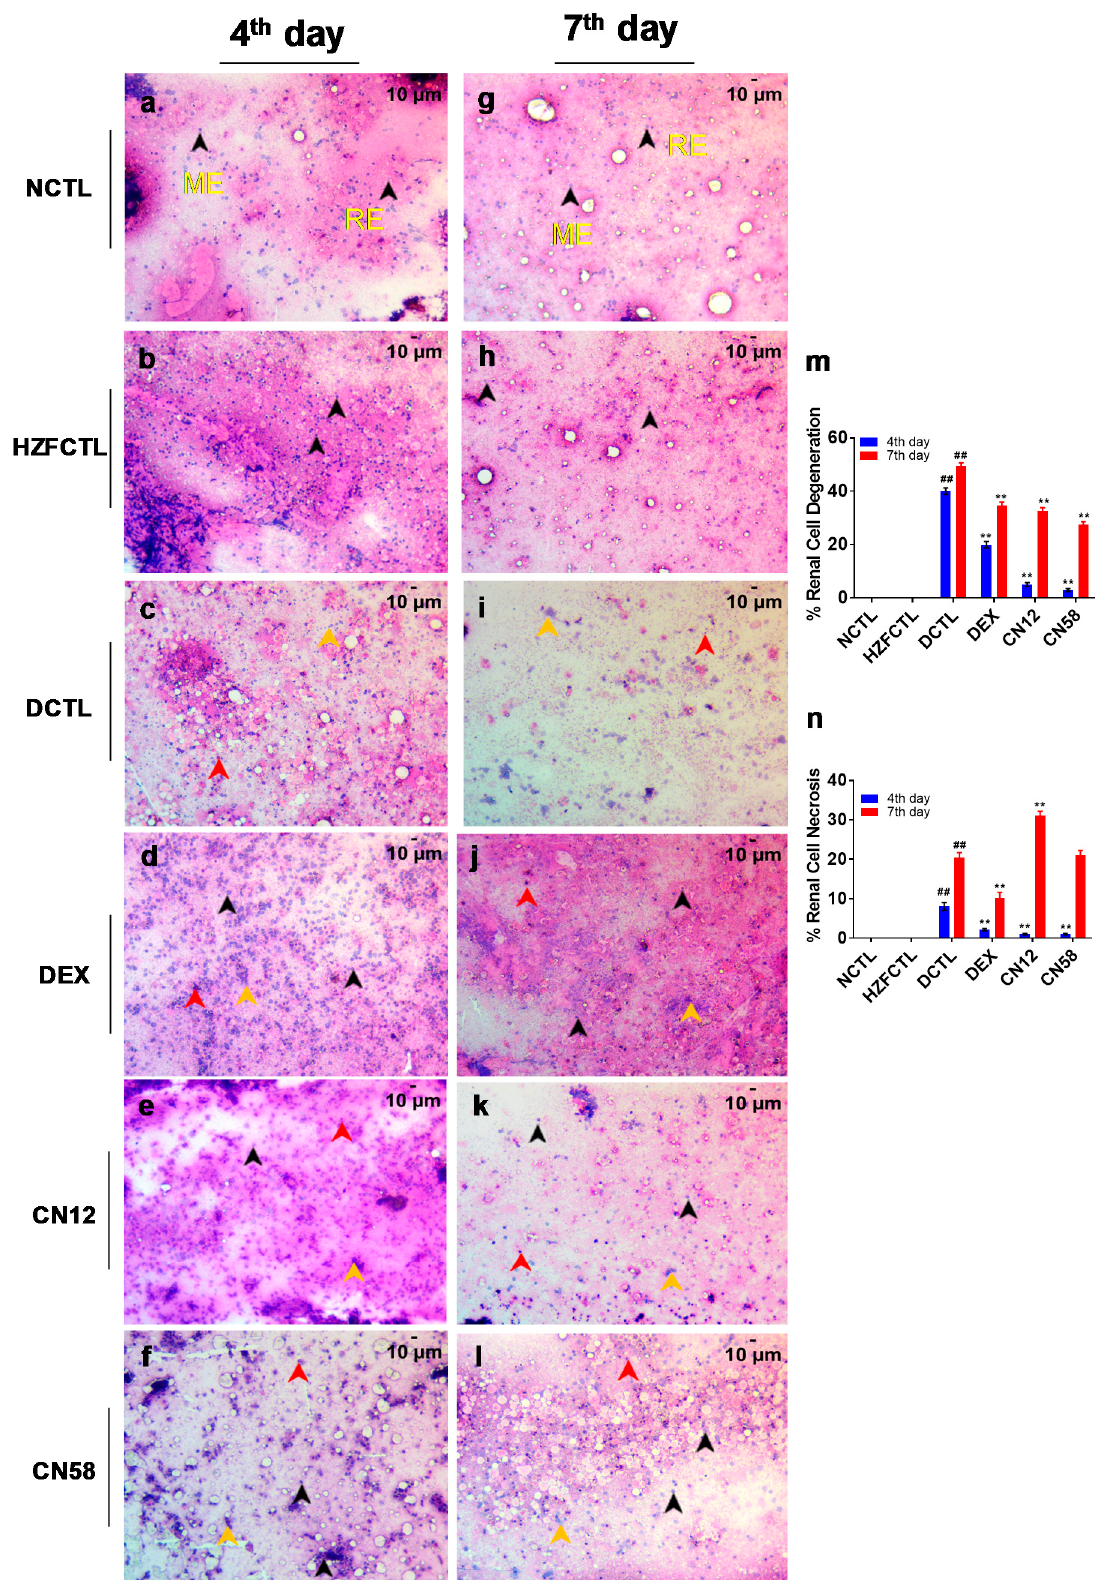
Figure 7. Coronil rescues from SARS-CoV-2 spike protein induced renal cell damage. Cytosmears of whole kidney necropsies were made and stained with H&E. The average degenerative and necrotic nuclei per 3 field were quantified to study renal pathological features at both the 4th and 7th day time points. ( a ) NCTL at 4th day, ( b ) HZFCTL at 4th day, ( g ) NCTL at 7th day, ( h ) HZFCTL at 7th day. NCTL and HZFCTL with apparent cytological features without any necrotic and degenerating cells.